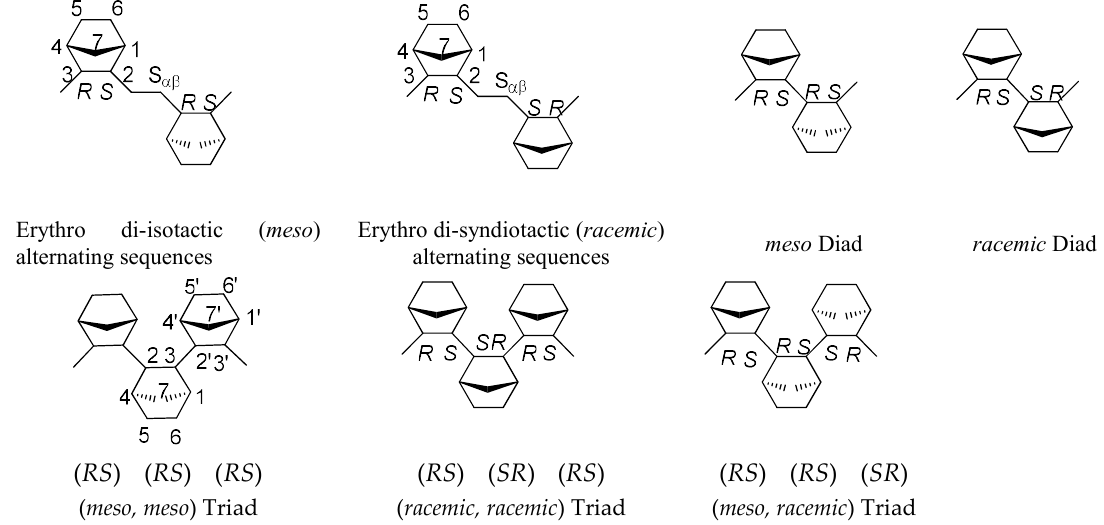
Scheme 2. Segments of E- co -N copolymer chain with the adopted numbering.